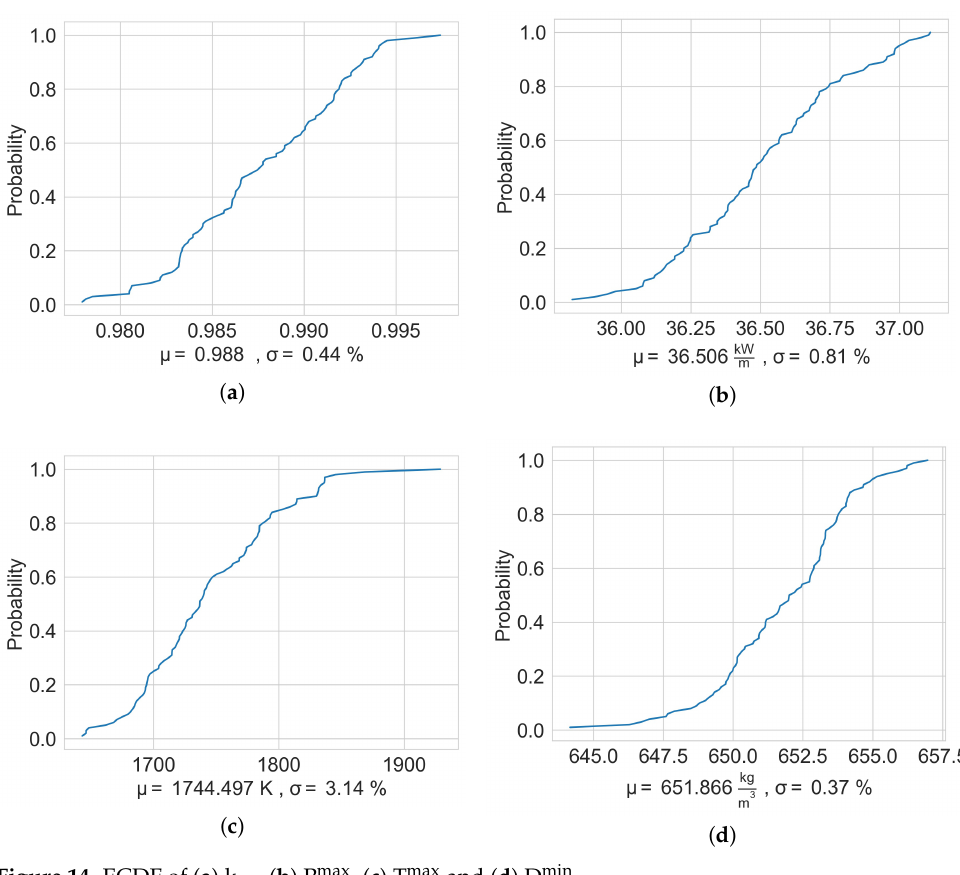
, ( c ) T max and ( d ) D min cool lin fc